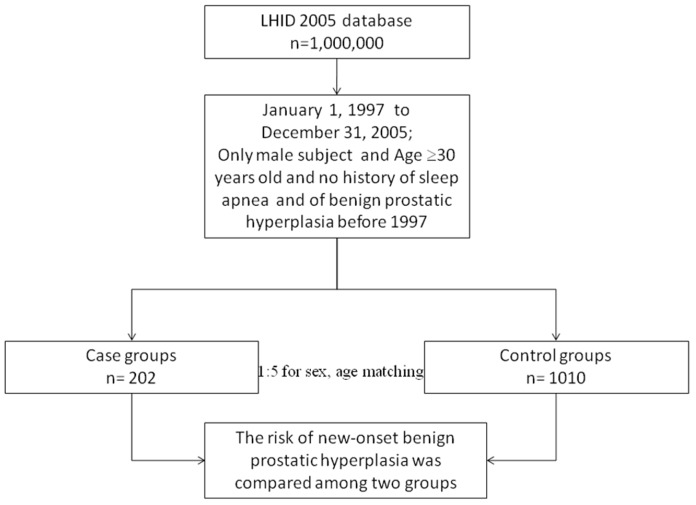
The research design flow chart of the present study.